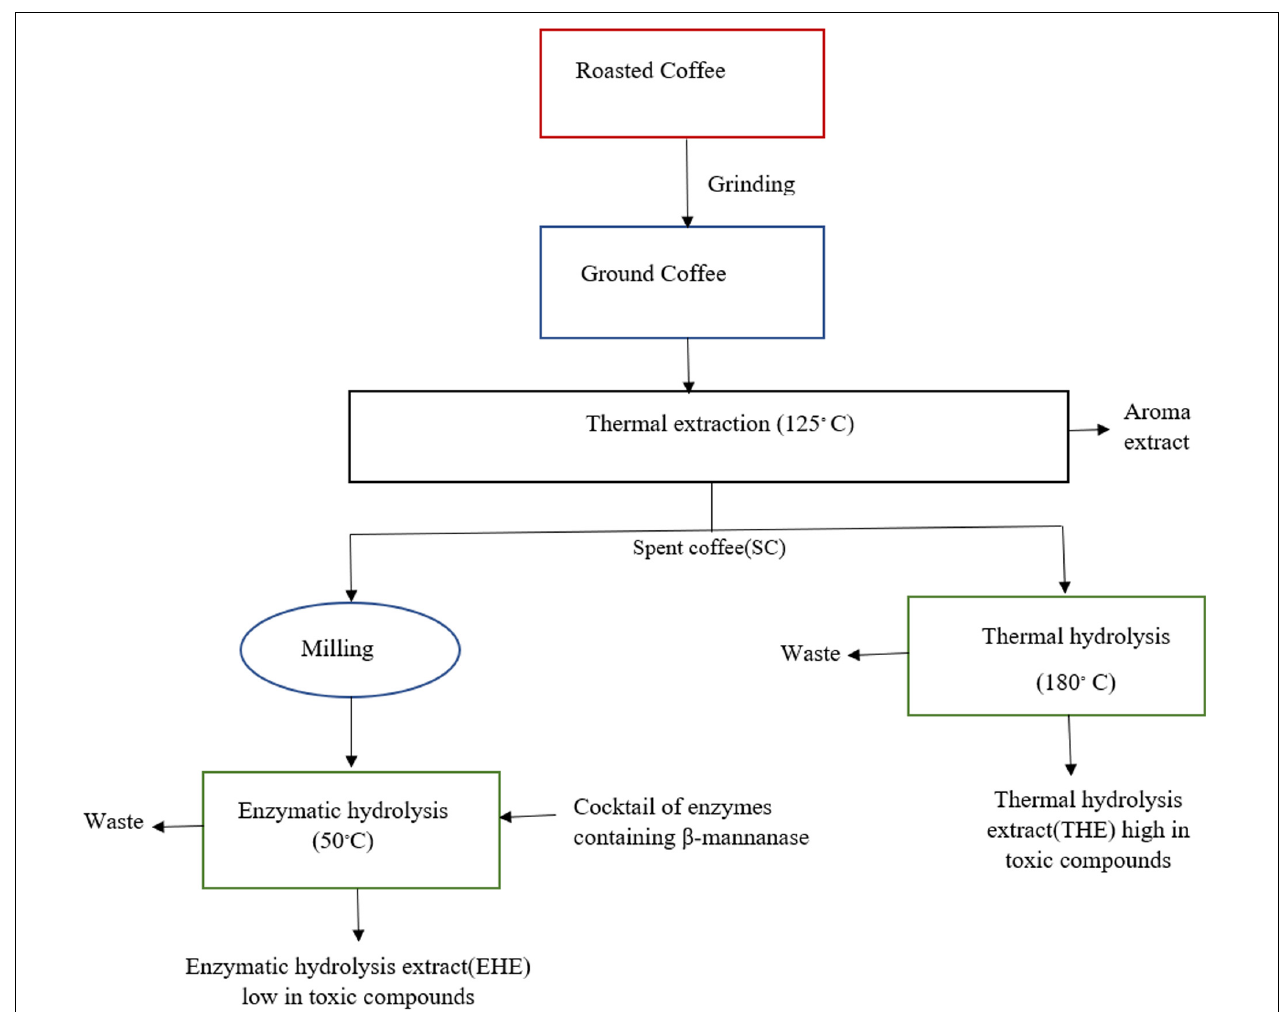
FIGURE 4 | Comparison of soluble coffee production by enzymatic and thermal hydrolysis. Modified from Baraldi et al.